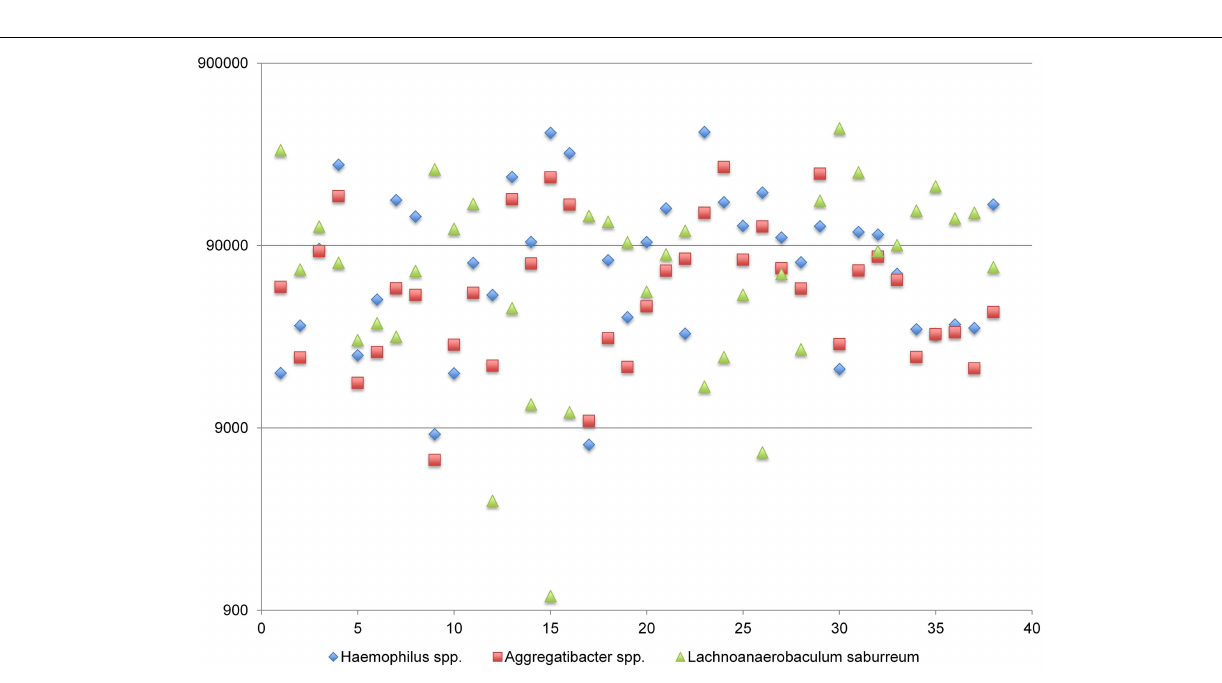
Frontiers in Cellular and Infection Microbiology